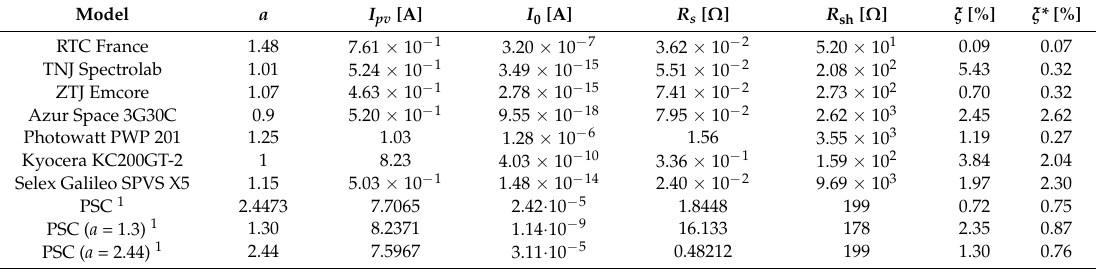
Table 10. Parameters from the 1-diode/2-resistor equivalent circuit model fitted to all studied curves. The values related to the plastic solar cell (PSC) I – V curve are best fit (calculated as the correspondent to the other technologies, see also [32]); analytical fitting where a = 1.30; and analytical fitting where a = 2.44). The normalized RMSE values of the fittings, ξ , and ξ * , are included in the table.